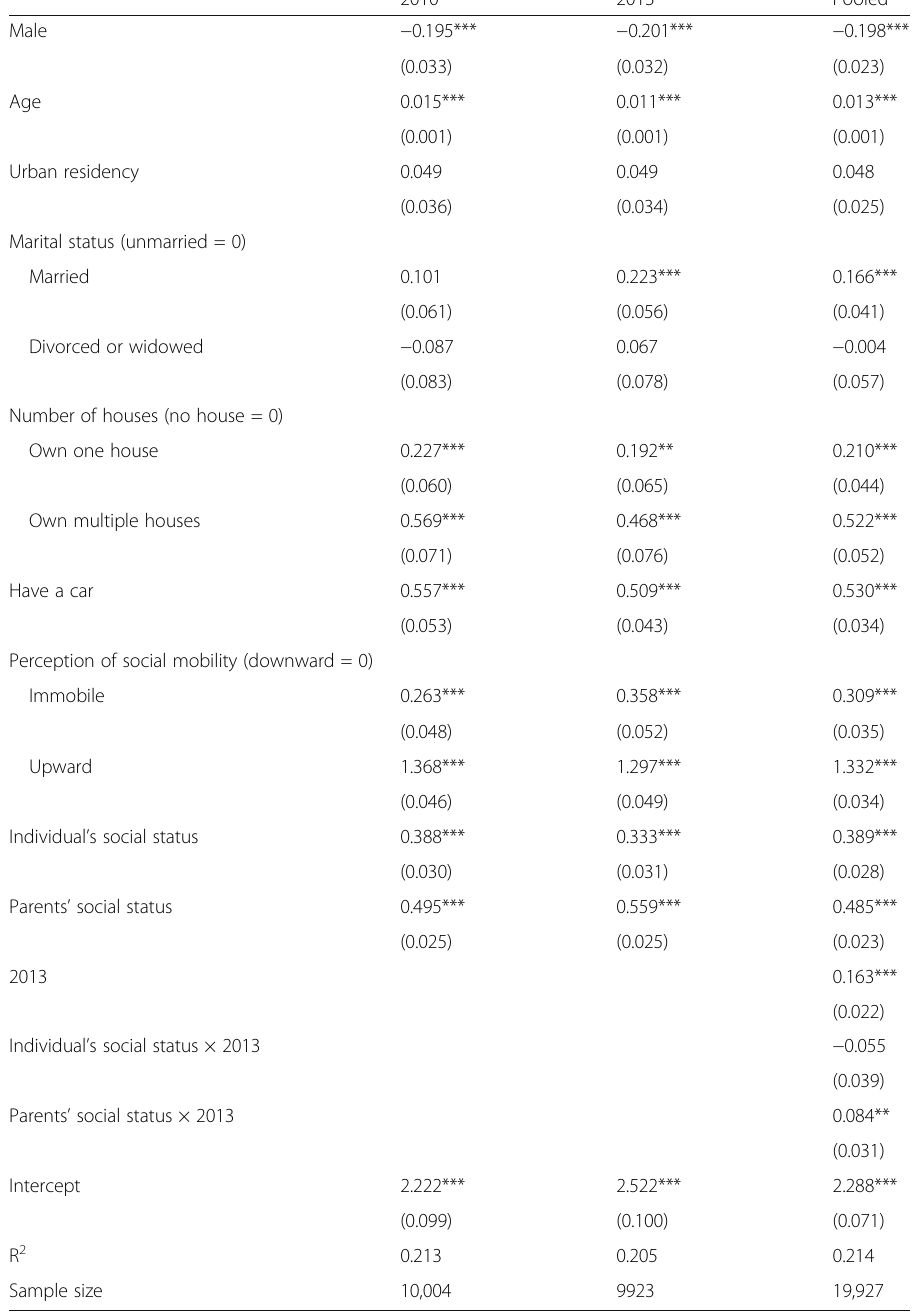
Table 6 Change in the effect of individual and parents ’ social statuses on class identity over time